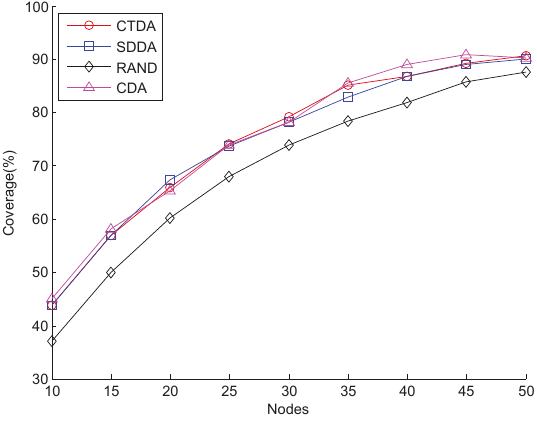
Figure 4. Coverage comparison with varying numbers of nodes.